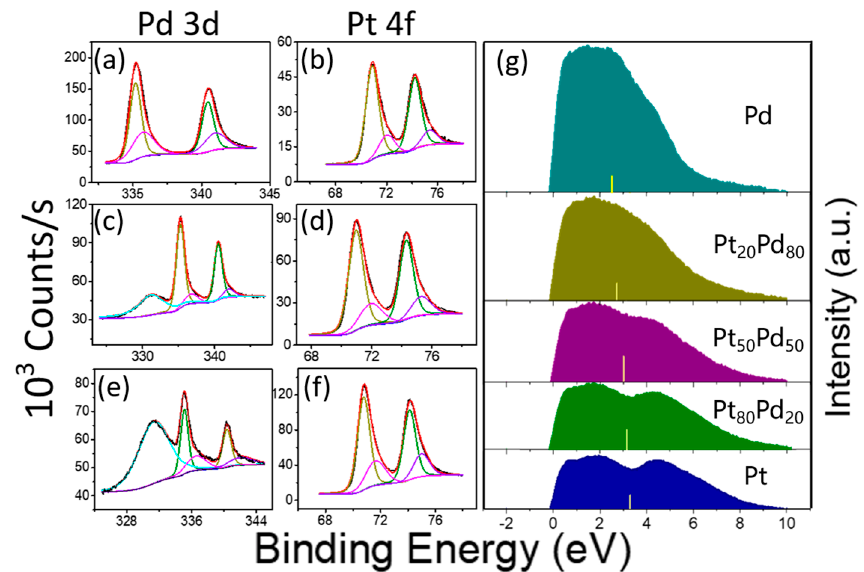
Figure 3. XPS spectra of ( a , b ) Pt 20 Pd 80 , ( c , d ) Pt 50 Pd 50 , and ( e , f ) Pt 80 Pd 20 aerogels; ( g ) surface valance band spectra of the Pt, Pd monometallic aerogels and Pt x Pd y bimetallic aerogels. All the spectra were corrected using a Shirley background. The yellow bars indicate the location of the d-band center. Table 1. Molar ratio of Pt/Pd and metal/metal oxides in the Pt x Pd y aerogels revealed from EDS and XPS and location of the d-band center of all the